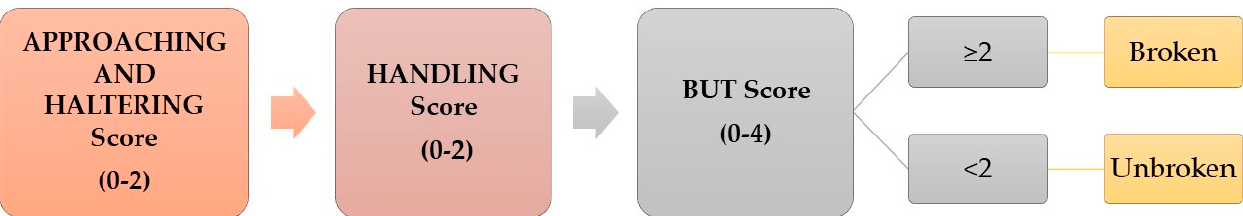
Figure 5. Proposed procedure to determine whether a horse is broken or unbroken. The horse’s behaviour during the Approaching and Haltering and Handling Tests should be scored on a 0–2 scale. The two scores are then summed to obtain the BUT score (range, 0–4). If the BUT score is ≥ 2, the horse should be identified as broken; if the BUT score is < 2, the horse should be identified as unbroken.